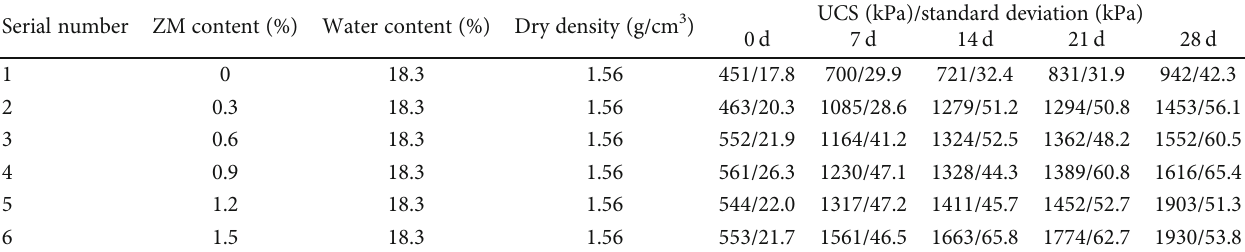
Table 3: Uncon fi ned compressive strength of the